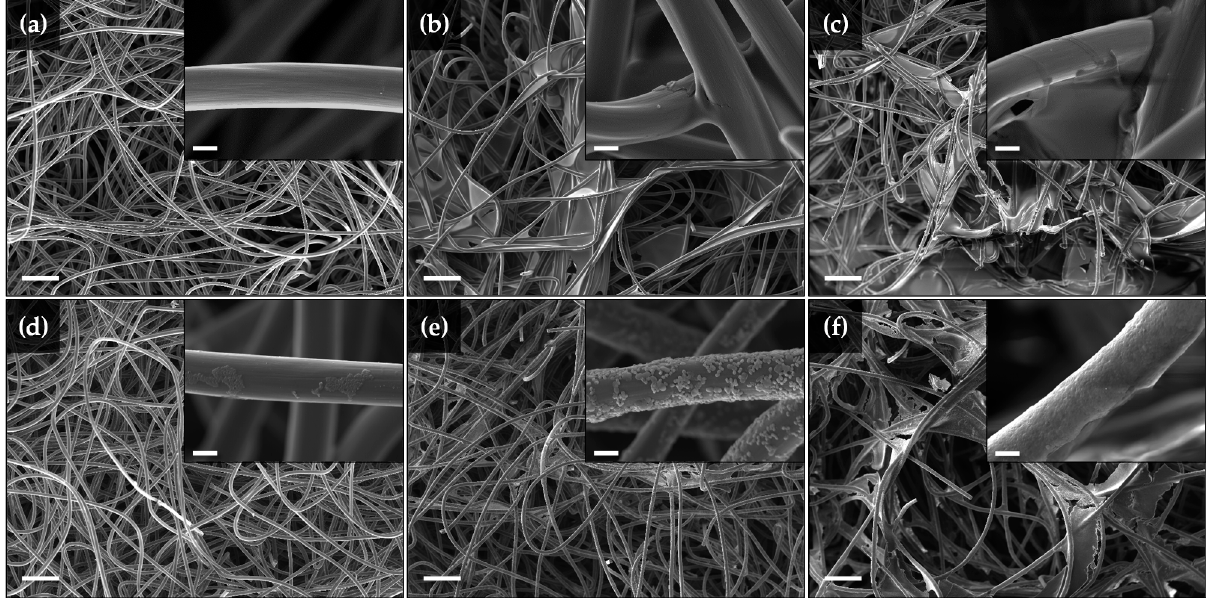
Figure 5. Scanning electron microscope images of graphite felt electrodes (GFEs) as cathodes before ( a – c ) and after ( d – f ) microbial electrosynthesis reaction by R. sphaeroides for 14 d. ( a , d ) bare GFE, ( b , e ) chitosan-modified GFE, ( c , f ) chitosan/carbodiimide compound-modified GFE. Scale bar, 100 μ m (inset, 5 μ m).